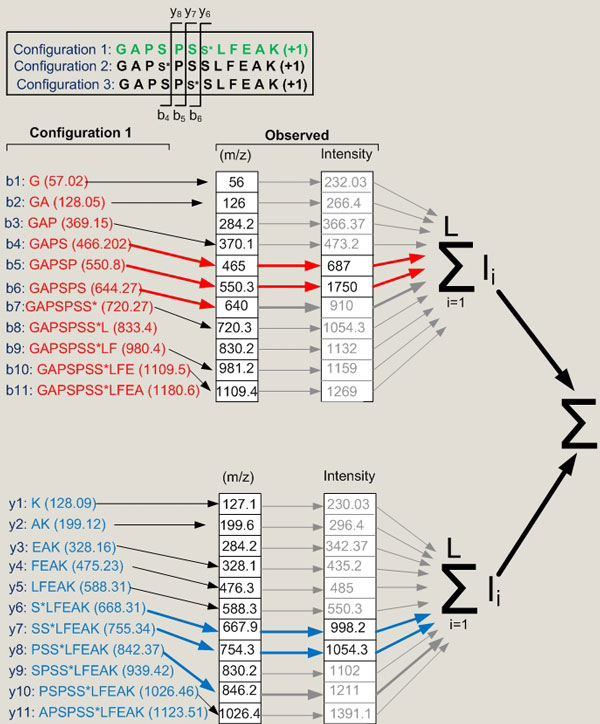
A diagram showing the concept behind the dynamic programming algorithm. Out of three candidate configurations, the site determining ions i.e. those fragment ions that would be specific for a particular phosphopeptide configuration, were established (b4 to b6 and y6 to y8, shown in top panel). The theoretical m/z of configuration 1 are shown. The observed m/z that only match (within a specified mass tolerance) to the theoretical site determining ions are then selected (indicated by red and blue arrows). The intensities of these site determining ions are then summed for each phosphopeptide configuration considered. Note that this diagram oversimplifies the problem because it ignores multiple charge states and neutral losses as discussed in text.